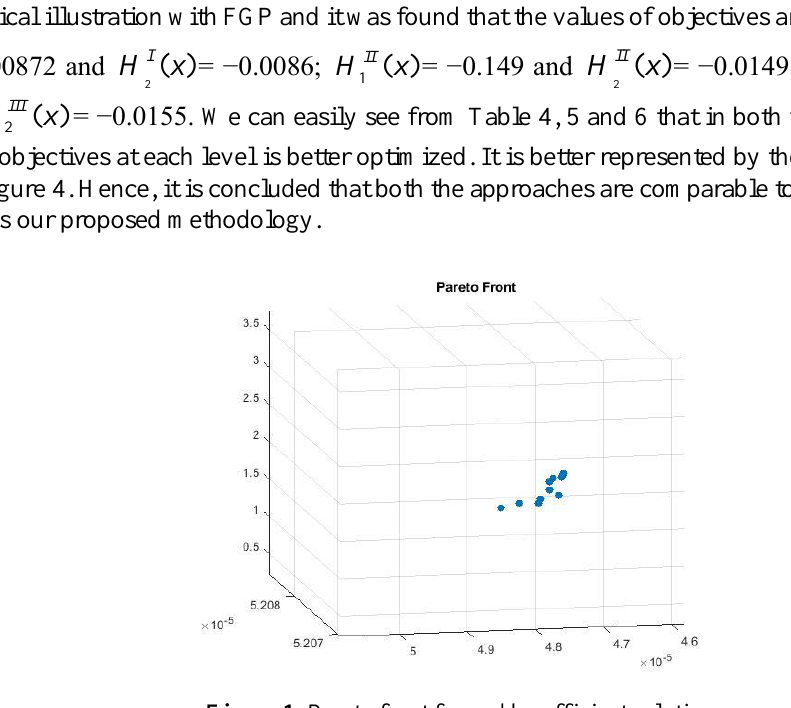
Figure 1. Pareto front formed by efficient